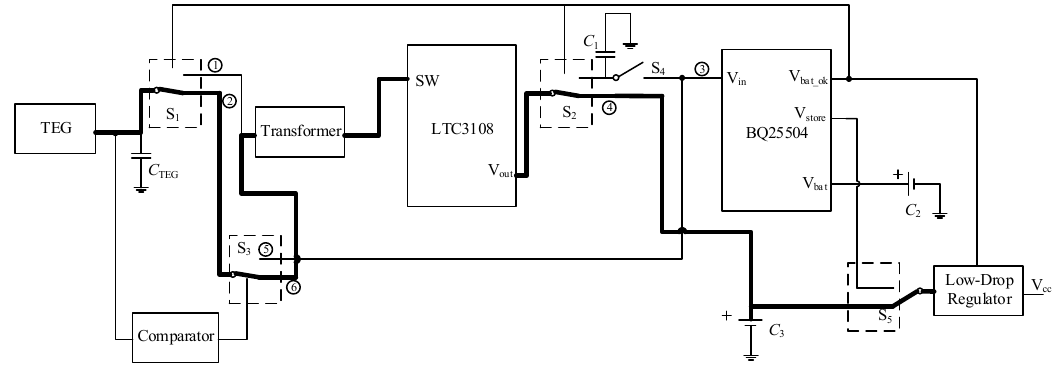
Figure 5. The ultra-low input period working principle of proposed PMS.